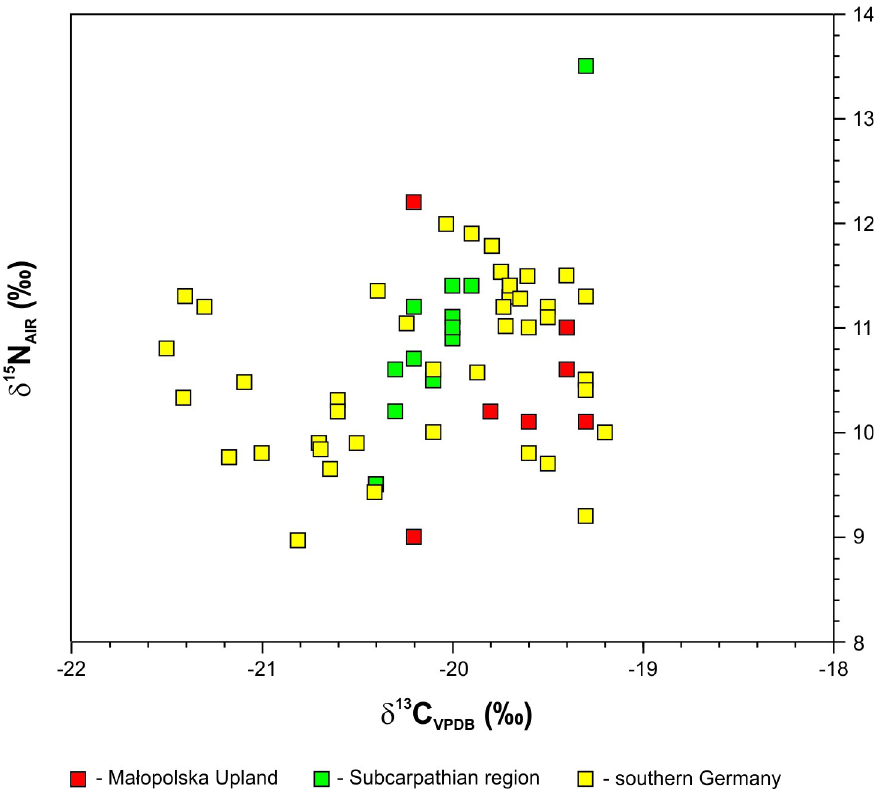
Fig 9. Plot of δ 13 C versus δ 15 N values for CWC humans from southwestern Poland compared to southern Germany populations of this culture [73].